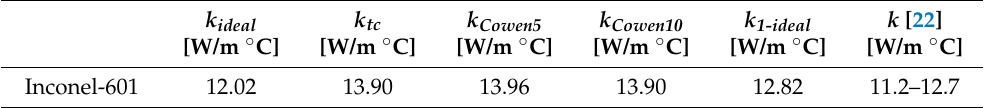
Table 3. Inconel 601: thermal conductivity values.